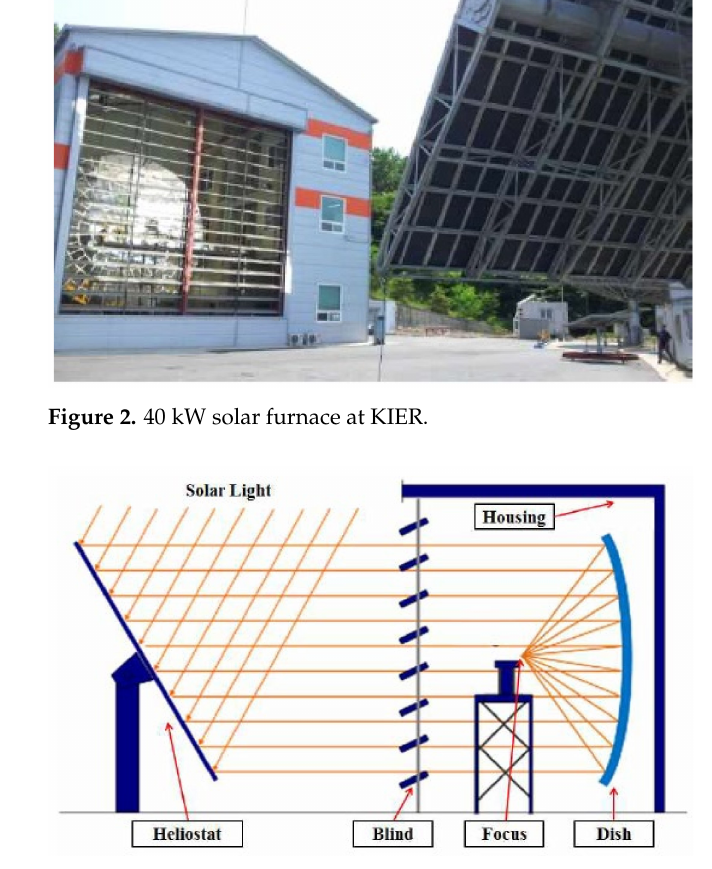
Figure 3. Schematic diagram of the solar